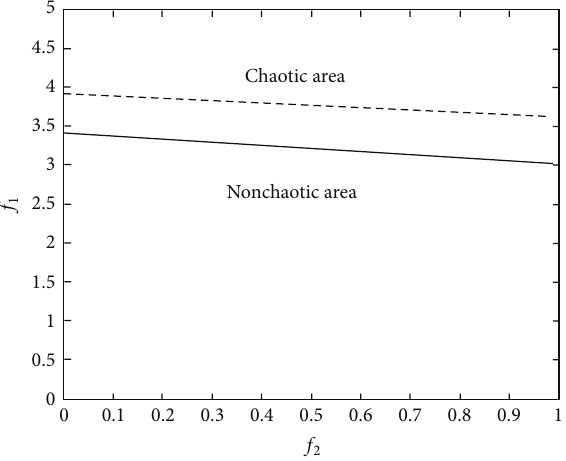
Figure 1: Chaotic area of system (1), —: theoretical solution and – ––: numerical